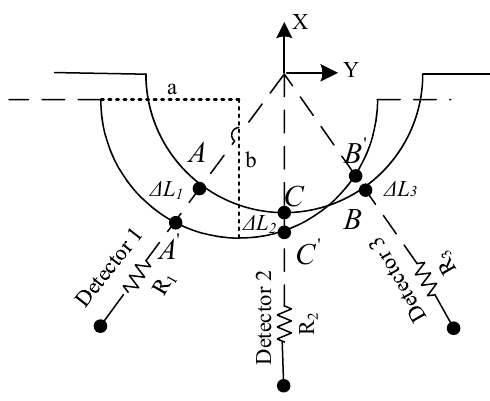
Figure 7. Schematic diagram of sensor.